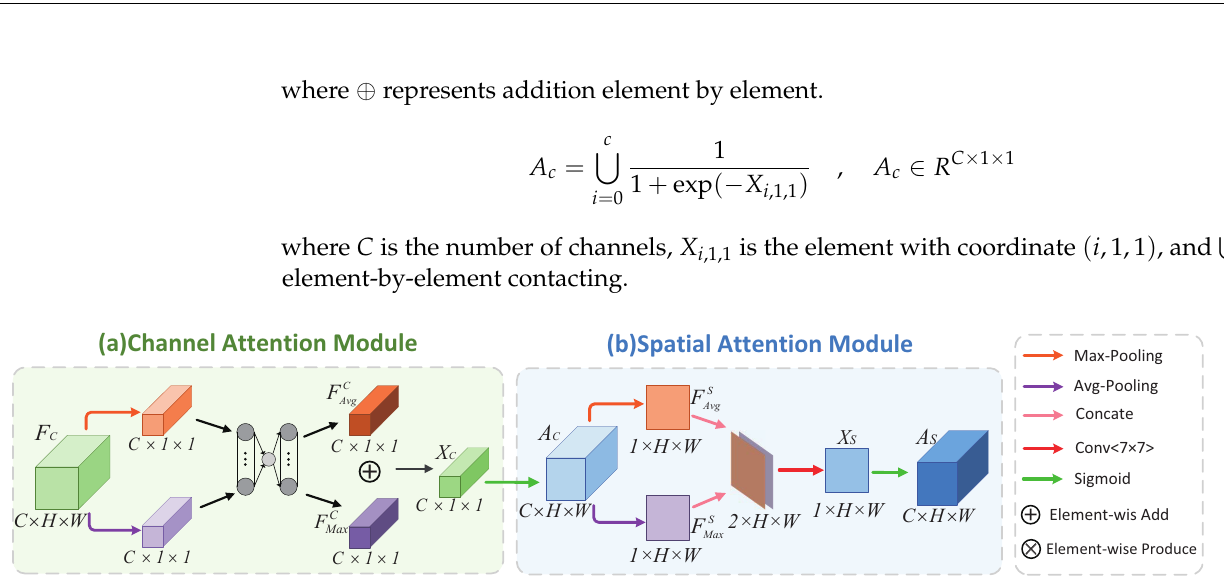
Figure 5. Attention module; ( a ) channel attention submodule; ( b ) spatial attention submodule. The Spatial Attention Module compresses the channel, and performs average pooling and maximum pooling in the channel dimensions. As shown in Figure 5b, the feature map A c ∈ R C × H × W output by the channel attention module is used as the input feature map of this module. First, the average pooling and maximum pooling operations along the channel axis are used to obtain two two-dimensional feature maps F S specific process is shown in Equations (9) and (10)), and then concat the two results based on the channel. The feature map of the merged 2 channels is subjected to a convolution operation to reduce the dimension to 1 channel to generate a spatial attention map Xs , as shown in Equation (8), where W and b represent MLP weight and MLP biase respectively. Cat (.) means concatenate. Conv (.) means convolution